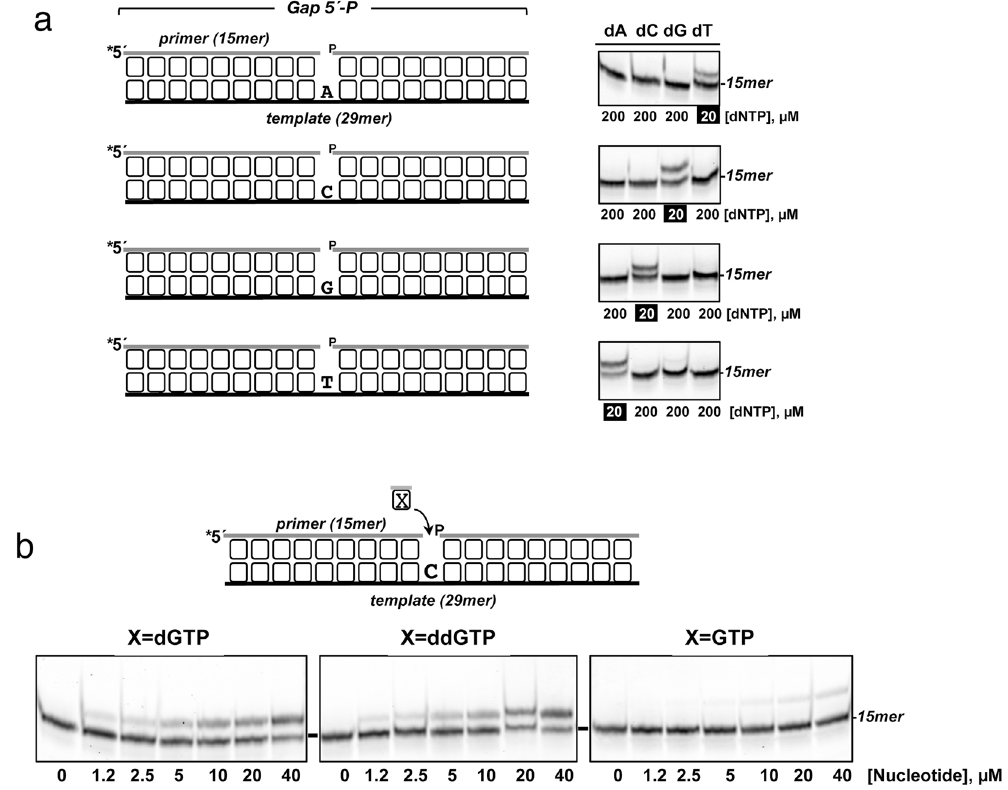
Figure 4. (a ) Pg VPolX is a template-directed DNA polymerase. The four different template-primer structures used, differing in the templating base of the 1-nt gaps, are shown on the left. The assay was performed as described in Materials and Methods with 25 nM of the indicated substrate, 3 nM of PgVPolX and either 20 µ M of the correct dNTP or 200 µ M of each of the three incorrect dNTPs. (b) Insertion of different types of nucleotides by PgVPolX . The assay was performed as described in Materials and Methods in the presence of 25 nM of the substrate depicted on the top of the panel, 3 nM of PgVPolX and the indicated concentrations of nucleotides. Asterisks indicate the 5 ′ Cy5-labeled end of the primer strand.